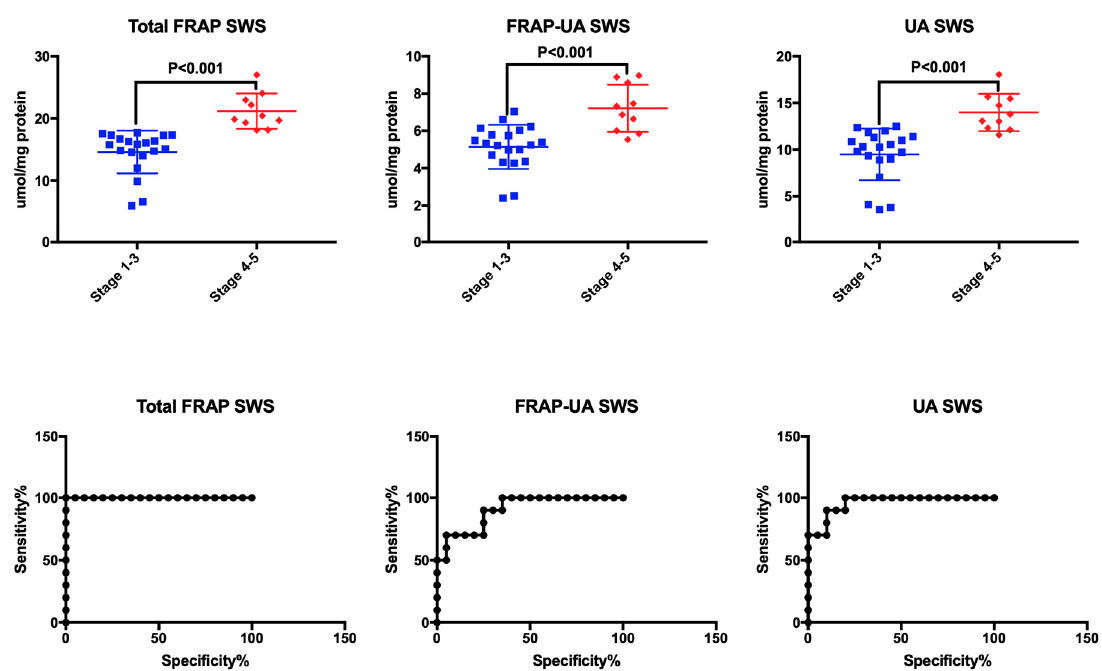
Figure 2. Receiver operating characteristic (ROC) analysis of total antioxidant capacity measured by FRAP in stimulated saliva of children at stage 1–3 and stage 4–5 of chronic kidney disease (CKD). FRAP—ferric ion reducing antioxidant parameter; FRAP-UA—UA-independent FRAP; SWS—stimulated whole saliva; UA—uric acid.